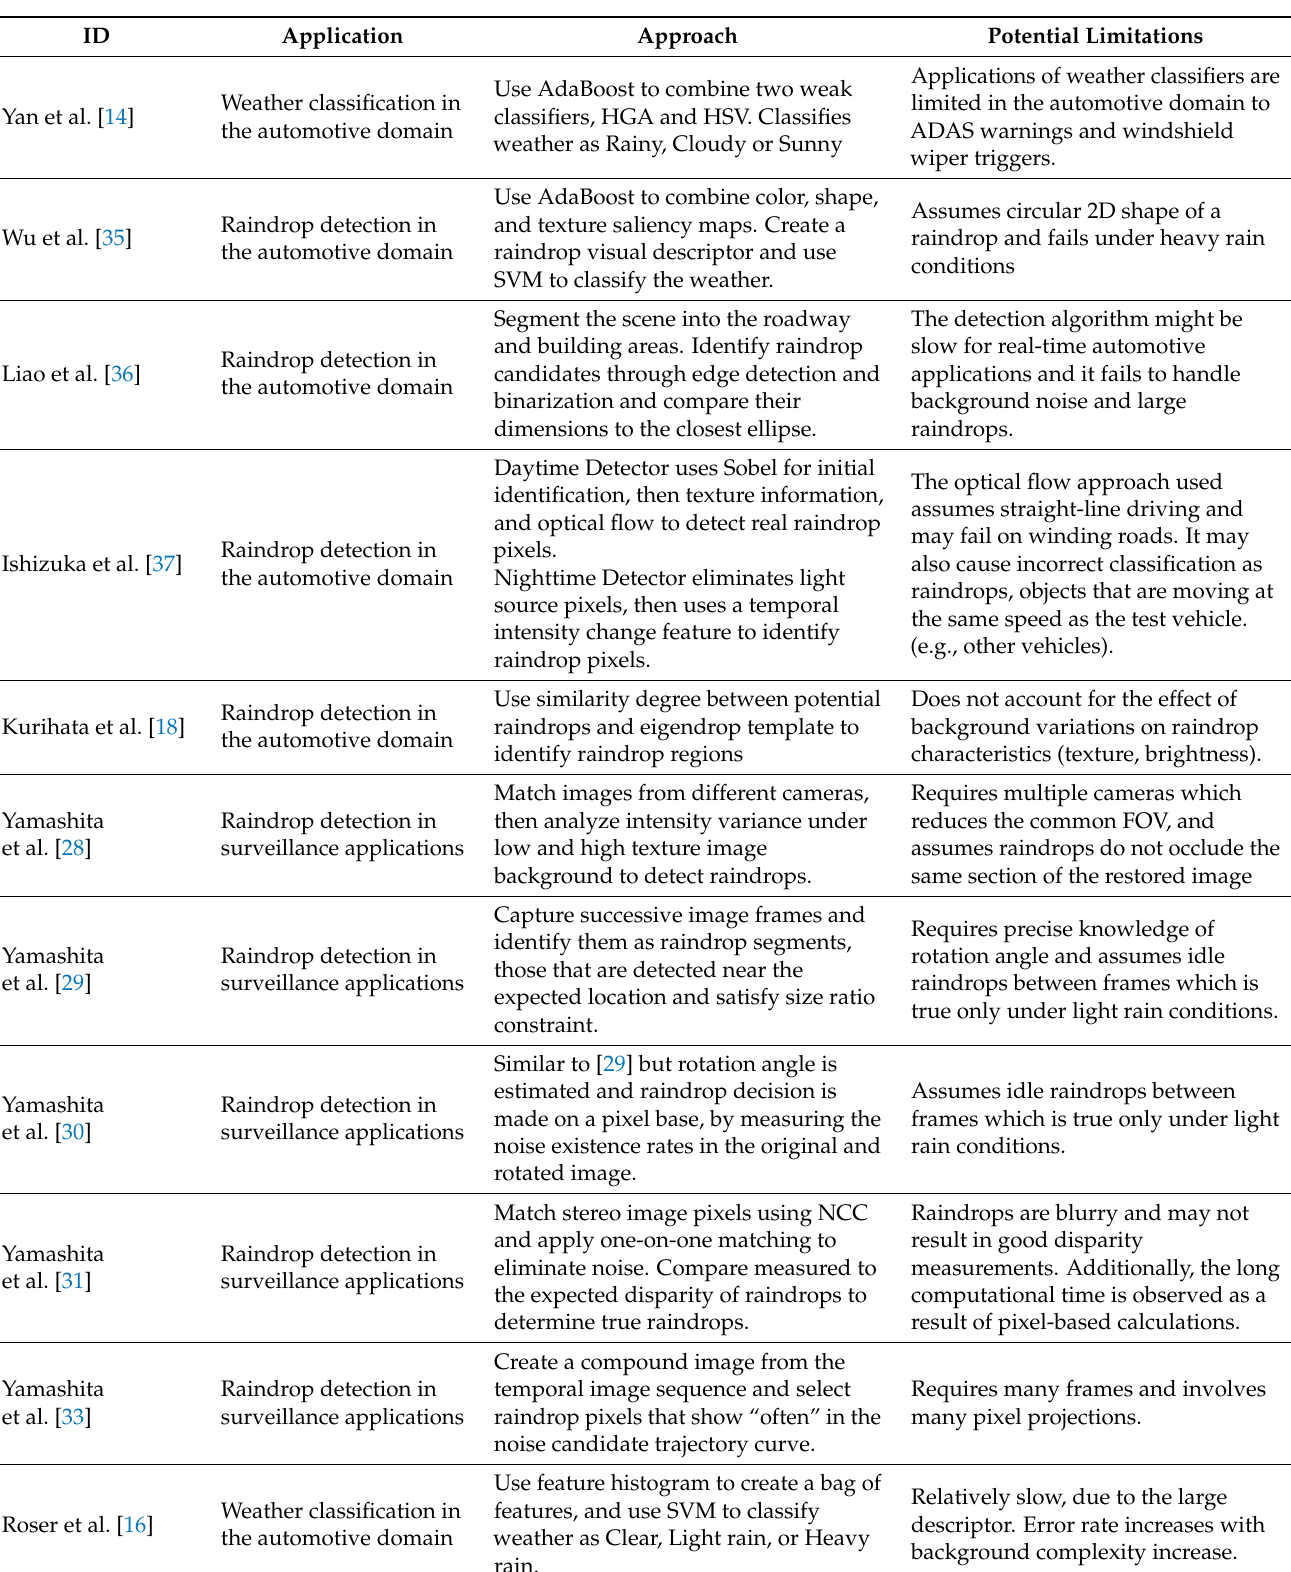
Table 4. Raindrop Detection-Classical